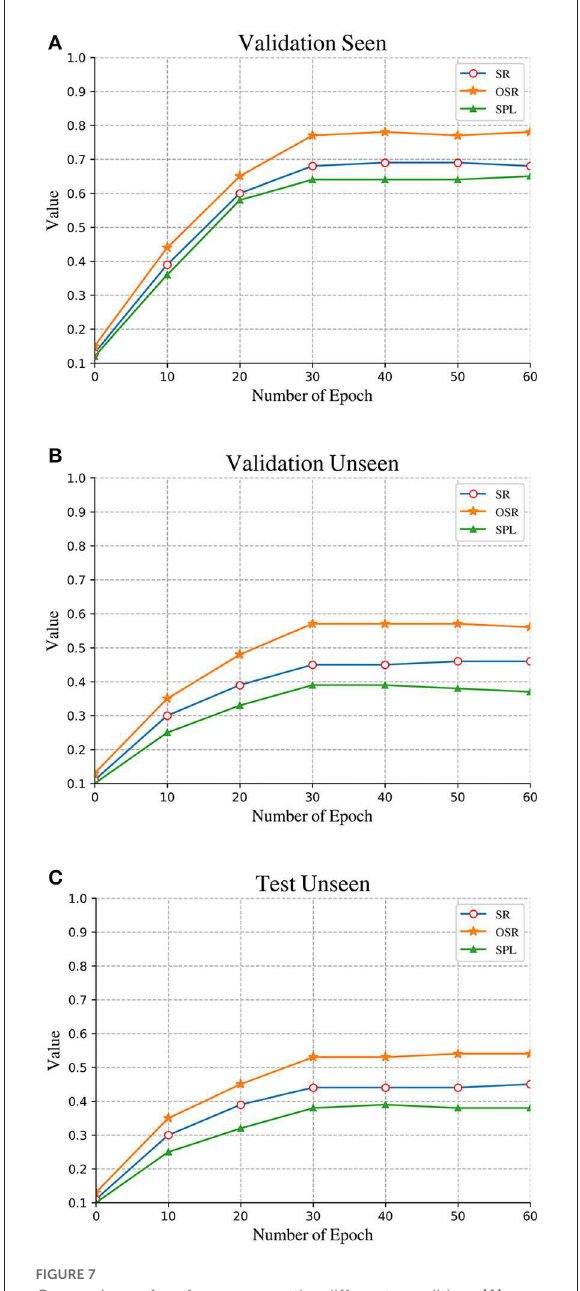
FIGURE7 Comparison of performance on the different condition: (A) Validation seen. (B) Validation unseen. (C) Test unseen.